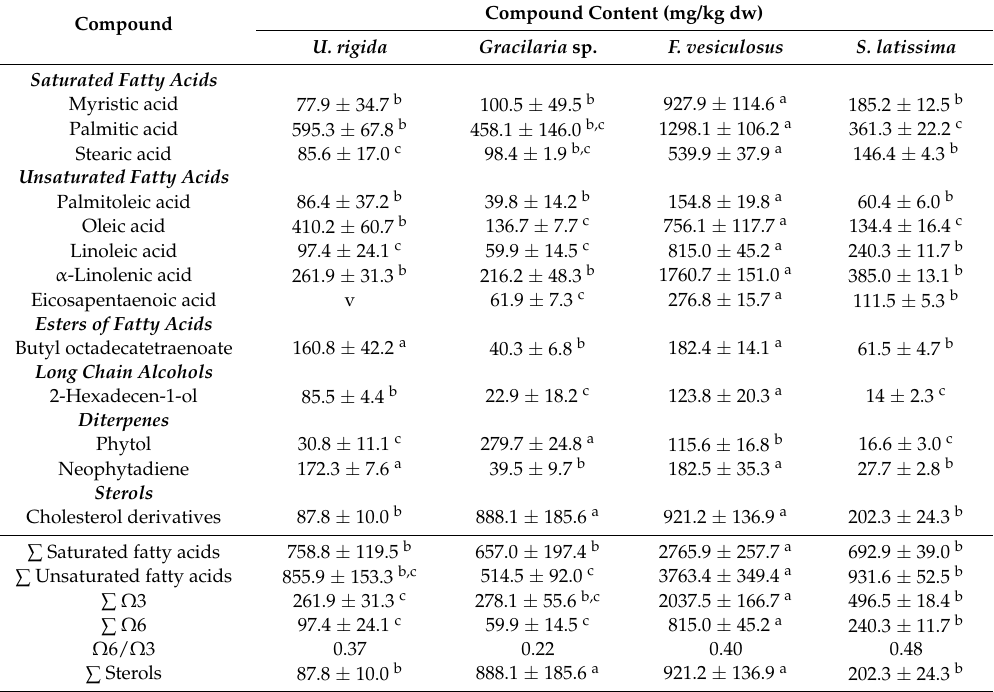
Table 2. Major lipid components of the four